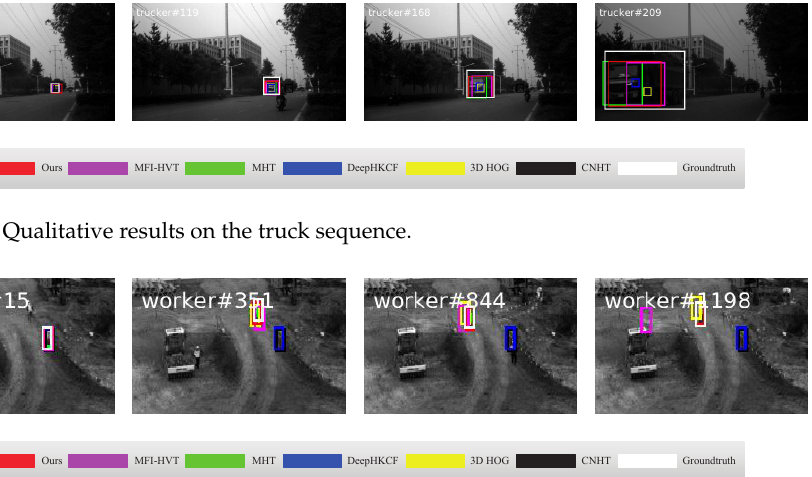
Figure 16. Qualitative results on the worker